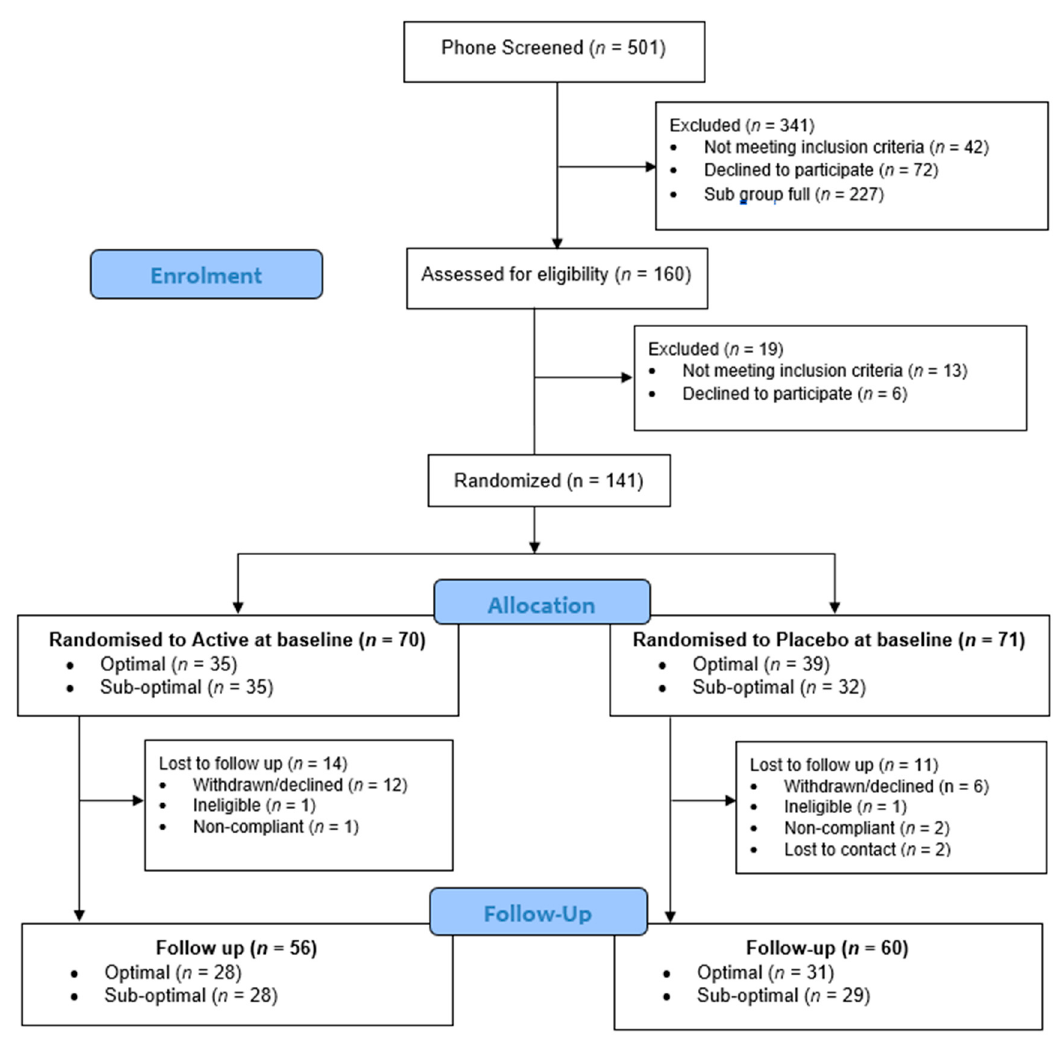
Figure 1. CONSORT diagram.